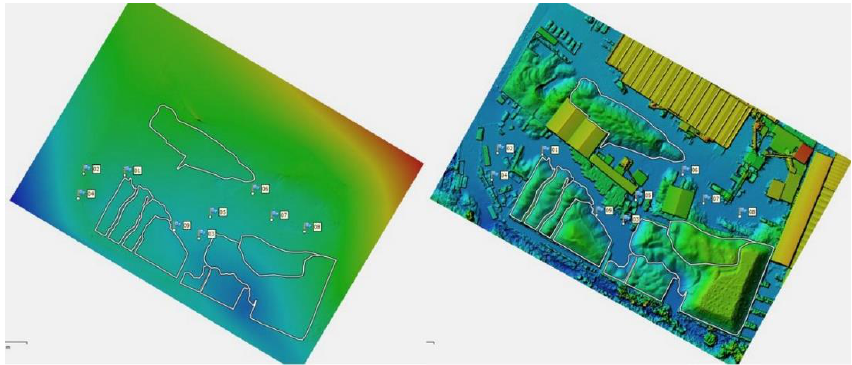
Figure 18. Photoscan, DEM of the ground ( left ) and upper surfaces ( right ).